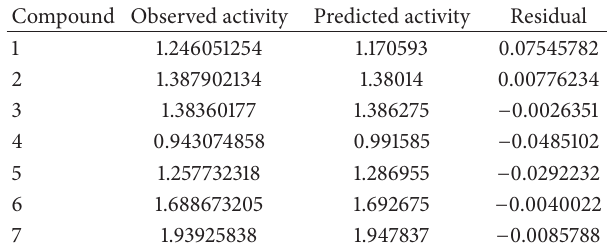
Table 6: Observed and predicted antibacterial activity of synthe- sized benzamide substituted Mannich bases against Staphylococcus aureus